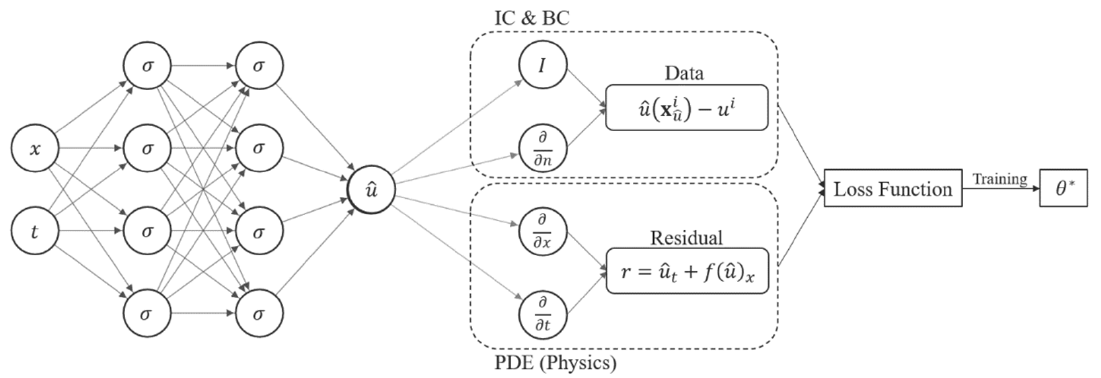
Figure 2. A representative PINN architecture for the solution of the hyperbolic Buckley–Leverett problem.